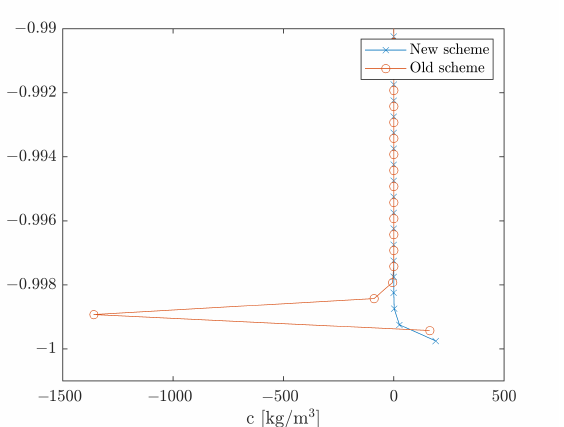
Figure 5. Comparison of the suspended concentration profiles near the bed produced by simulations using the old and new Gauss